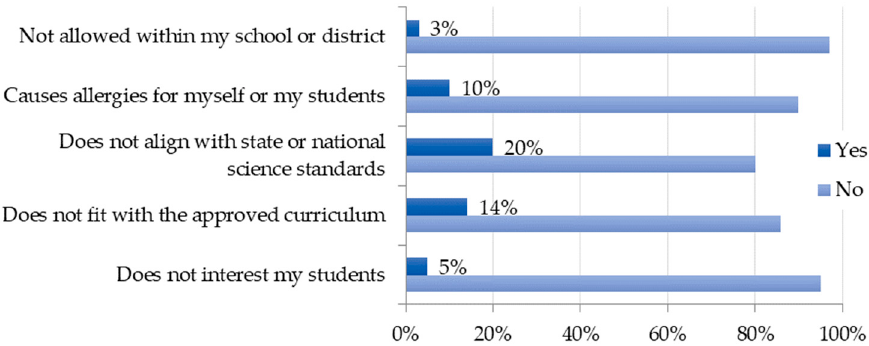
Figure 6. Barriers to insect incorporation.